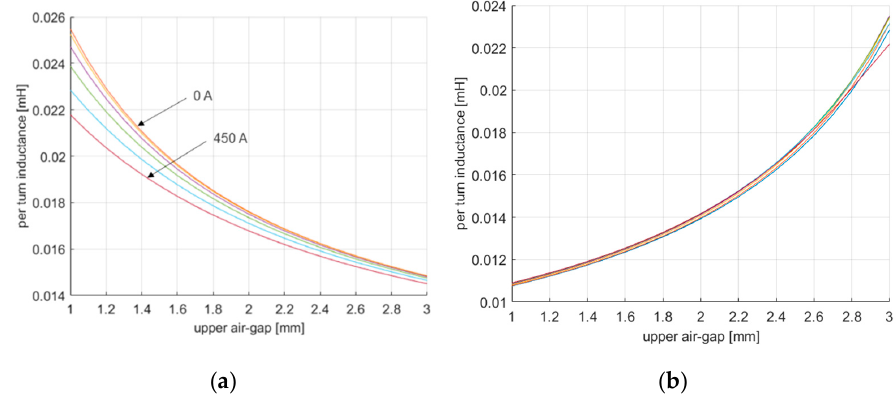
Figure 14. Per-turn inductance as a function of g u for di ff erent ampere-turn values; ( a ) upper winding; ( b ) lower winding.